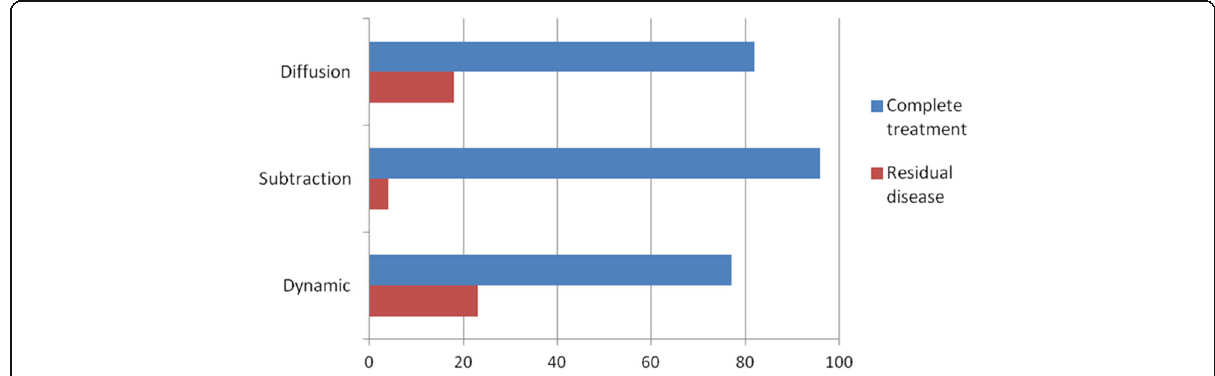
Fig. 5 Horizontal graph showing the correlation of reader 3 findings to standard of reference (expressed as